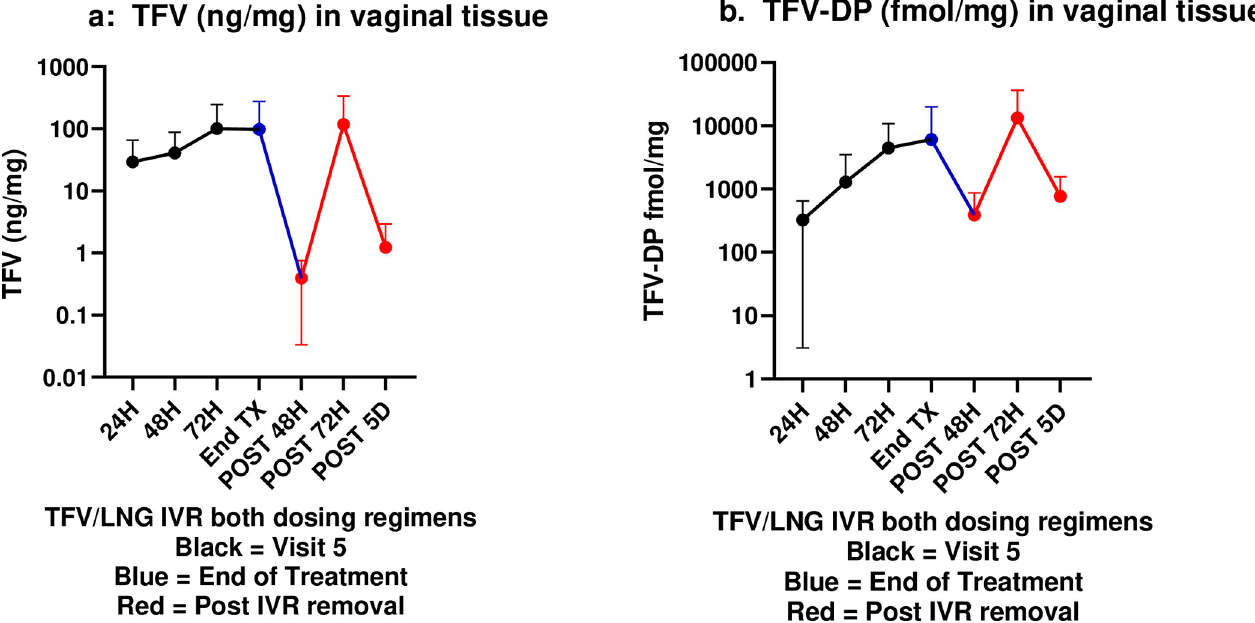
Fig 3. a. Median (IQR) tenofovir concentration (ng/mg) in vaginal tissue. b. Median (IQR) TFV-DP concentration (ng/mg) in vaginal tissue. Black = visit 5 (24, 48 or 72 hours post IVR insertion), Blue line = end of treatment; Red = post IVR removal.